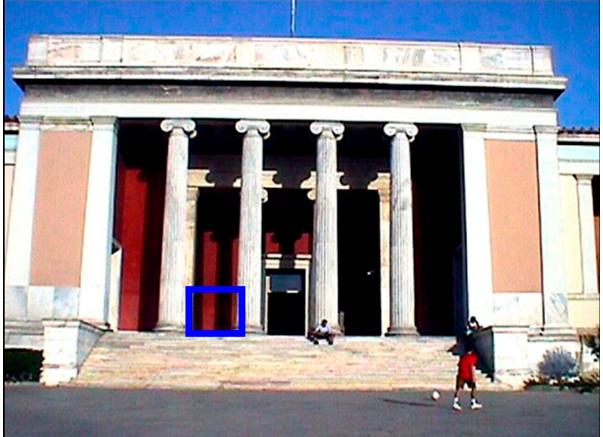
Figure 19. Façade of the National Archaeological Museum of Athens: The blue box indicates the plastered area of propylaem, investigated by IRT.